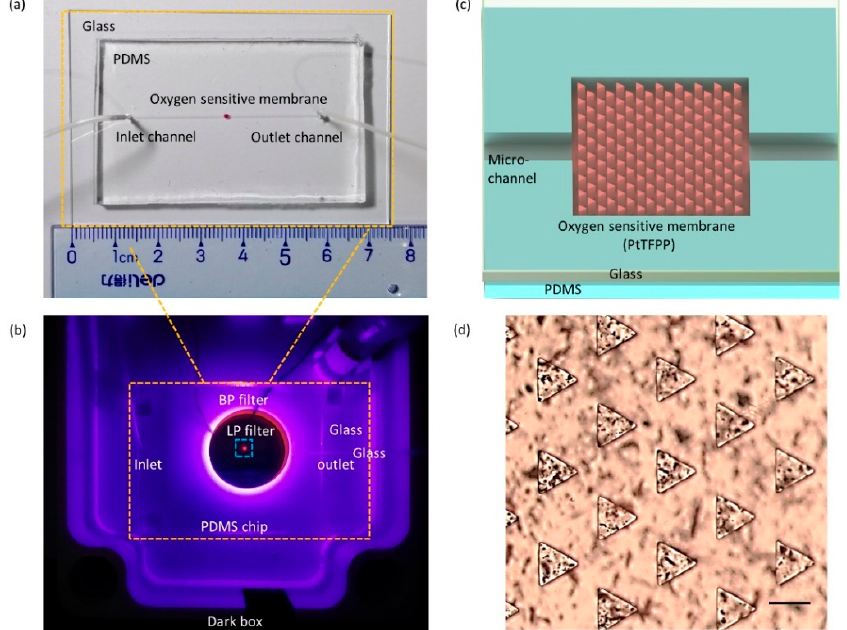
Figure 2. The image of the microfluidic chip incorporated with oxygen-sensitive membrane ( a ) and image shows the optical elements arrangement and phosphorescence emitting of the intelligent sensor ( b ). ( c ) The schematic diagram of the microchannel incorporated with microstructure-assisted PtTFPP/polydimethylsiloxane (PDMS) sensor film. ( d ) The microscope image of patterned microstructures. Scale bar: 50 μ m.